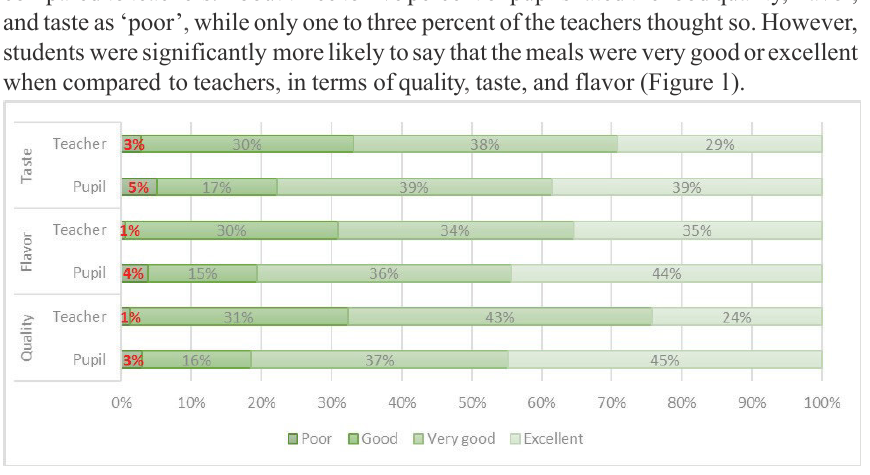
Fig. I: Perception of General Quality, Flavor, and Taste of MDM Source: Field